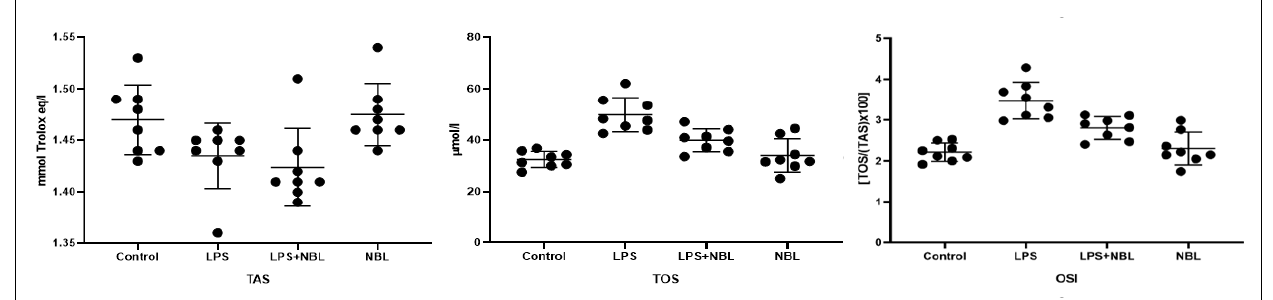
Figure 4. TAS, TOS, and OSI Levels in Lung Tissue. LPS: Lipopolysaccharide, NBL: Nebivolol,